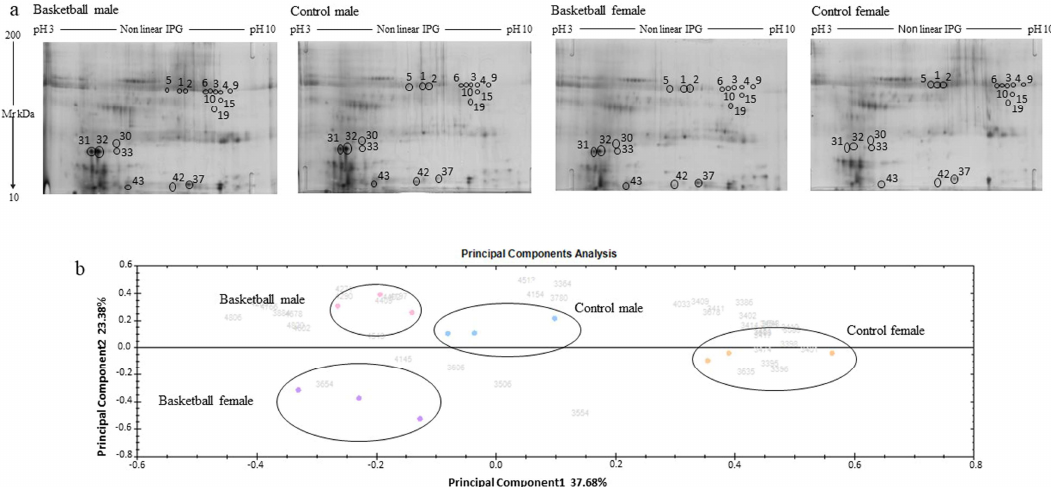
Figure 1. Proteomic profile of Basketball players and controls. ( a ) Representative 2DE images of silver-stained gels of saliva proteins run on NL pH 3–10 IP strip and in 9–16% polyacrylamide linear gradient. Circles and numbers indicate statistically differentially abundant proteins between the four groups analyzed, as reported in Table 2. ( b ) Multivariate analysis of the 2DE gel images results using Principal Components Analysis (PCA) performed by Progenesis SameSpots 4.0 software (Nonlinear Dynamic, UK).